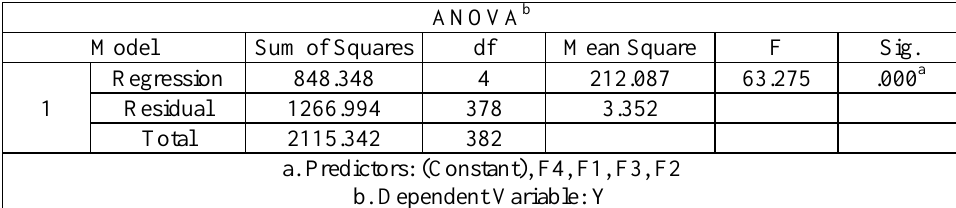
Table. 10. Results of Variance Analysis Test (ANOVA) (Comparison of Mean) Coefficients